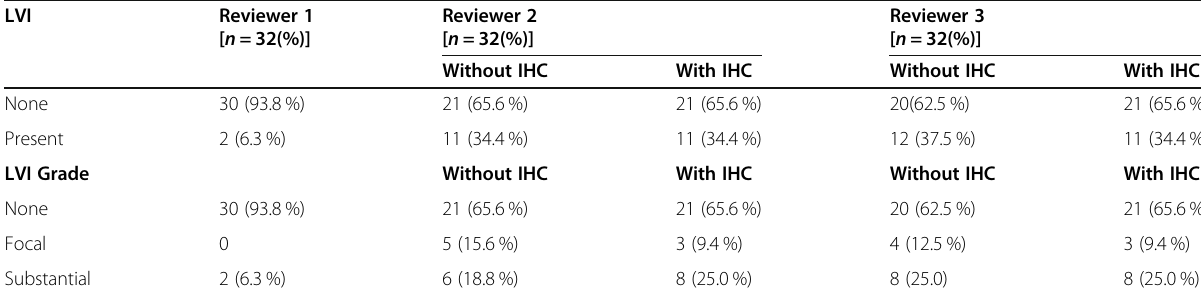
Table 2 LVI Positivity amongst reviewers before and after Immunohistochemistry